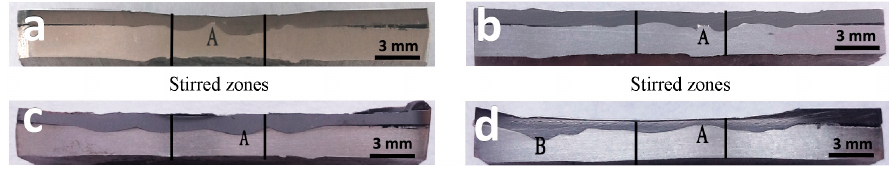
Figure 6. Weld cross-section morphology of FSKSW: ( a ) AZ31/DP600; ( b )